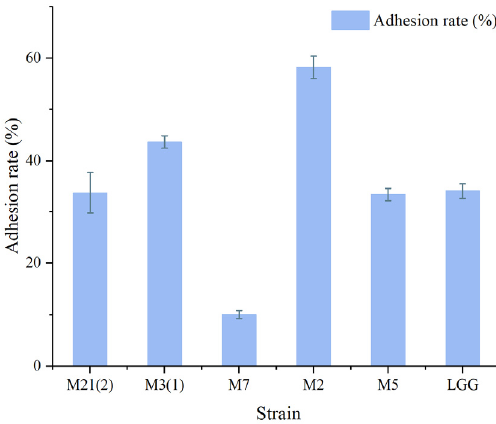
Figure 4. Adhesion rate of